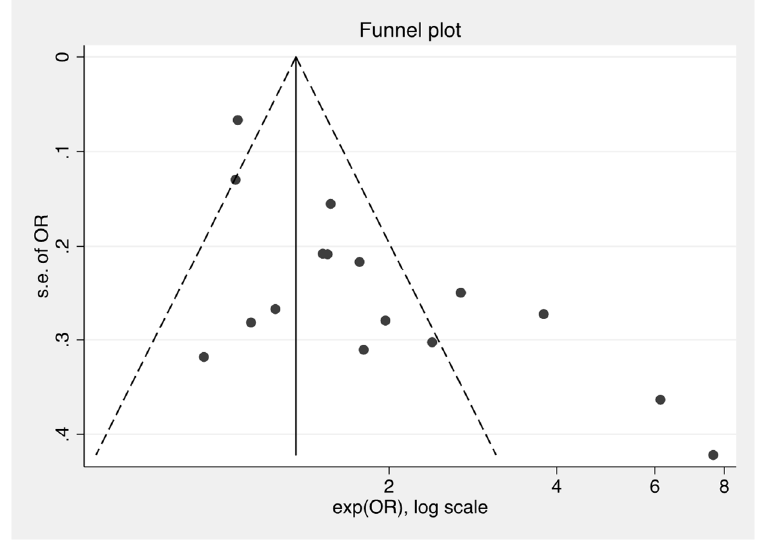
Figure 4. Funnel plot for publication bias.